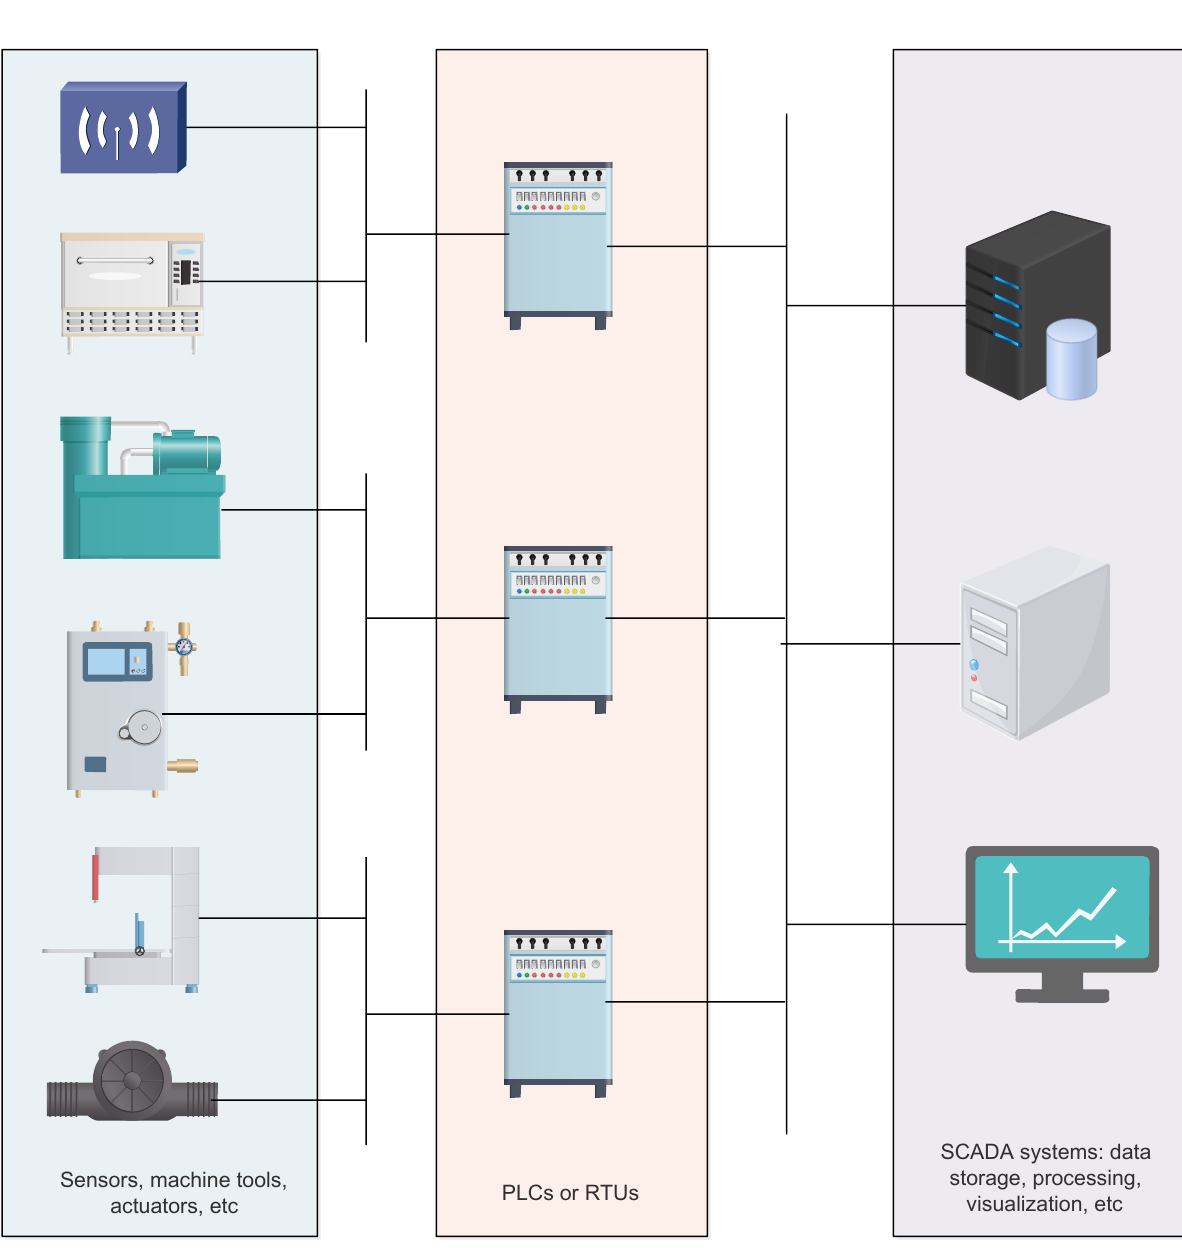
Figure 2. Basic architecture of a SCADA